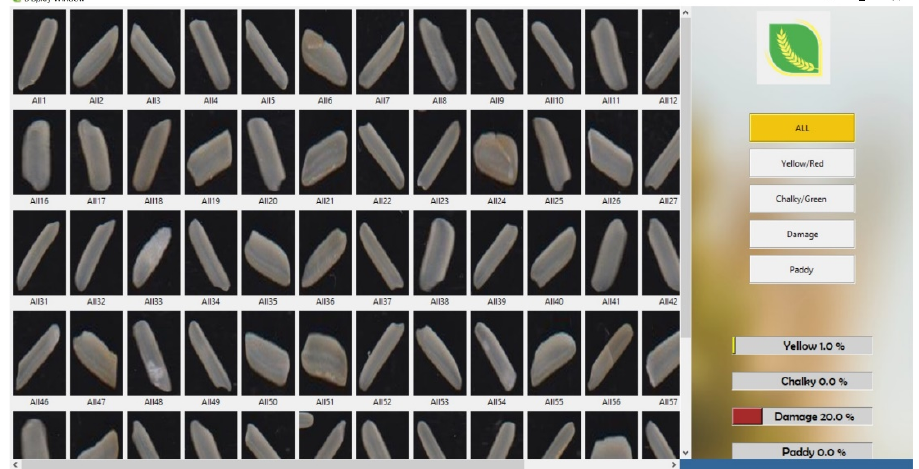
Figure 15 . National Grain Tech - generated quality analysis image. Figure 15. National Grain Tech - generated quality analysis